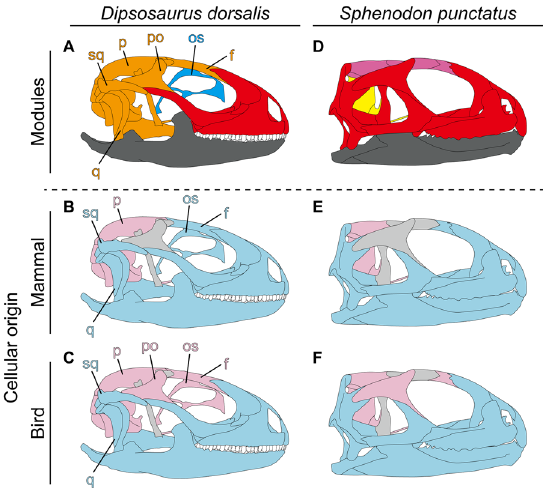
Figure 4. Comparison of the skull modules of lizards and tuatara with the cellular origin patterns. Based on Noden and Trainor (2005) 2 , ( A – C ) skulls of lizards (Dipsosaurus dorsalis ) and ( D – F ) tuatara are color-coded for mammalian and bird cellular origin patterns (blue, the neural-crest-derived elements; pink, mesoderm- derived elements; gray, non-homologous elements). Abbreviations: f, frontal; os, orbitosphenoid; p, parietal; po, postorbital; q, quadrate; sq, squamosal.